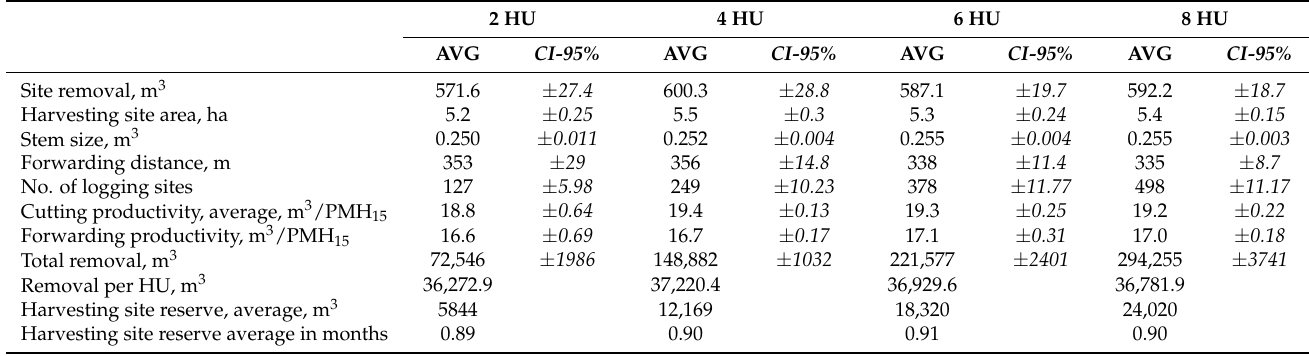
Table 9. Parameter data of harvesting sites and machine performance among simulation scenarios of 2, 4, 6, and 8 HU. Presented are 95% confidence intervals of 7 replications.